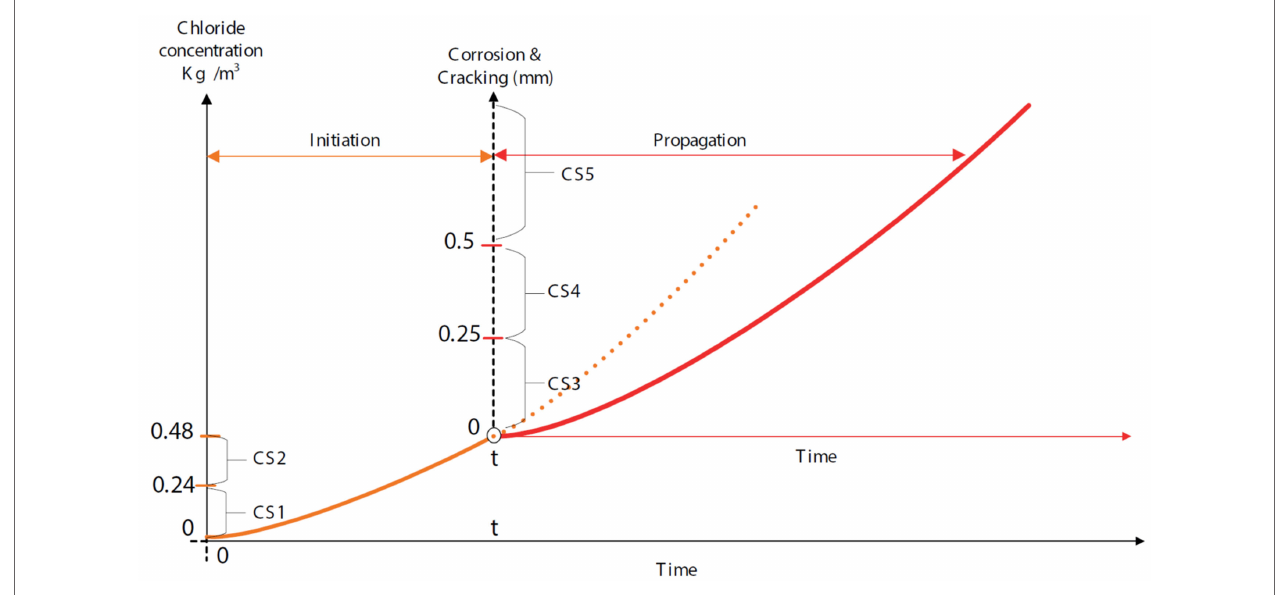
FIGURE 1 | Deterioration process of reinforced concrete due to chloride-induced corrosion [adopted from Lethanh et al. (2017)].